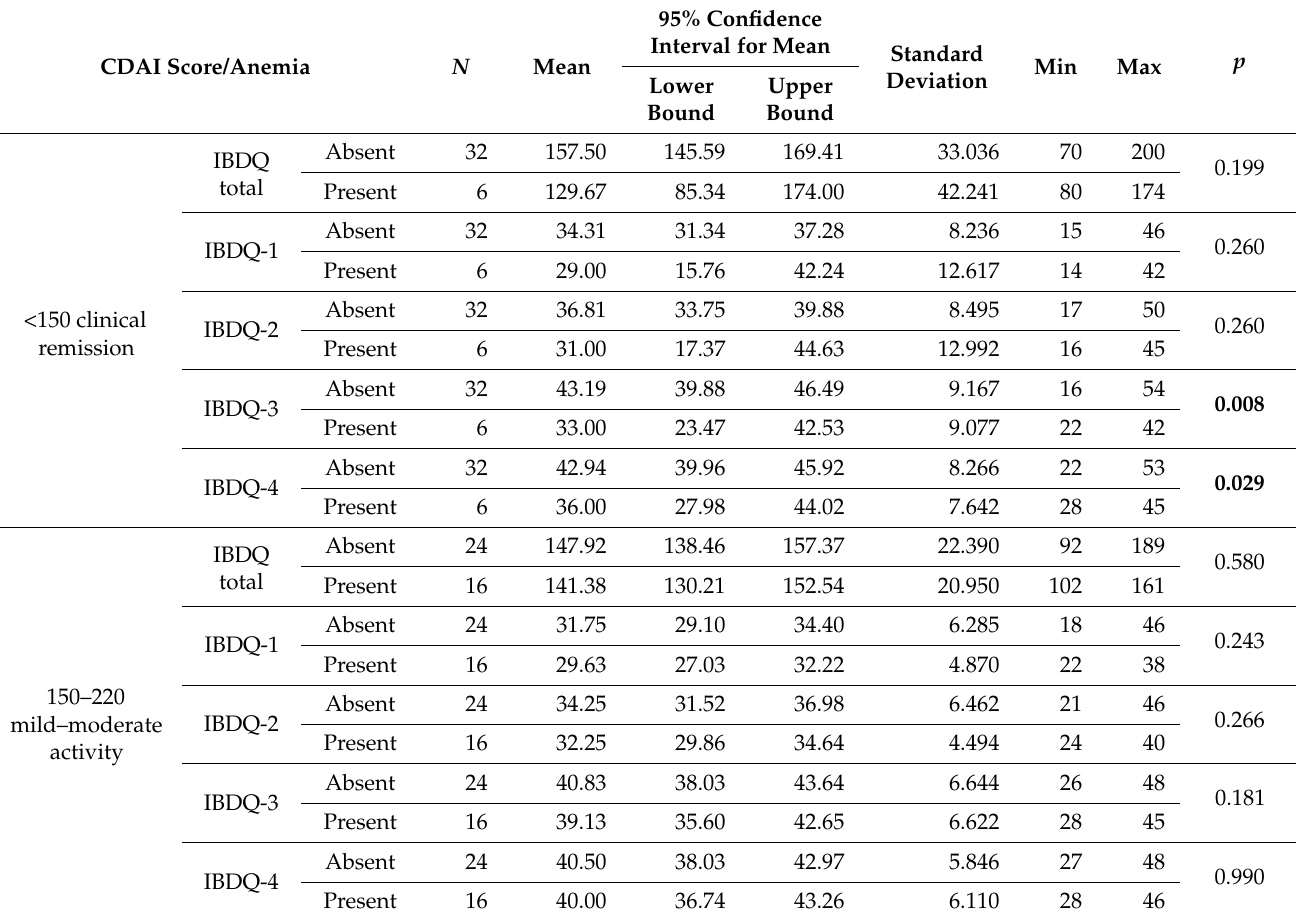
Table 5. Influence of anemia on quality of life in relation to the activity severity.